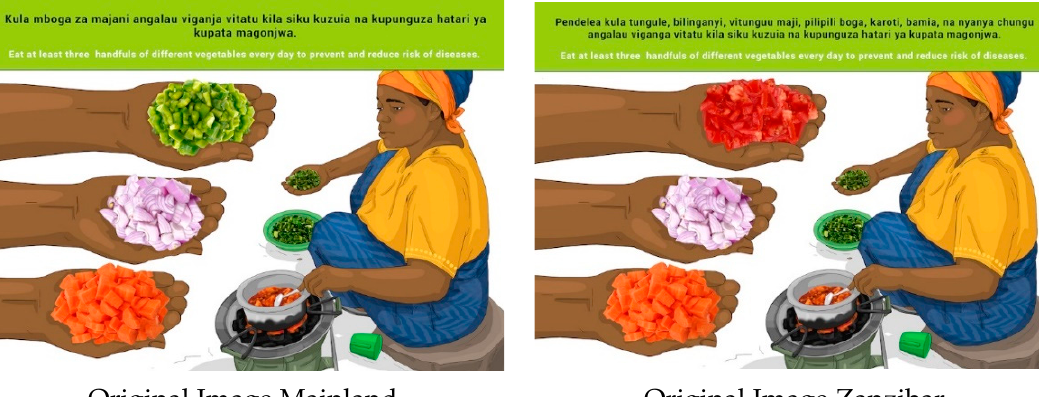
Figure 4. Eat animal source foods, including seafood, meat, milk or eggs every day to stay strong.